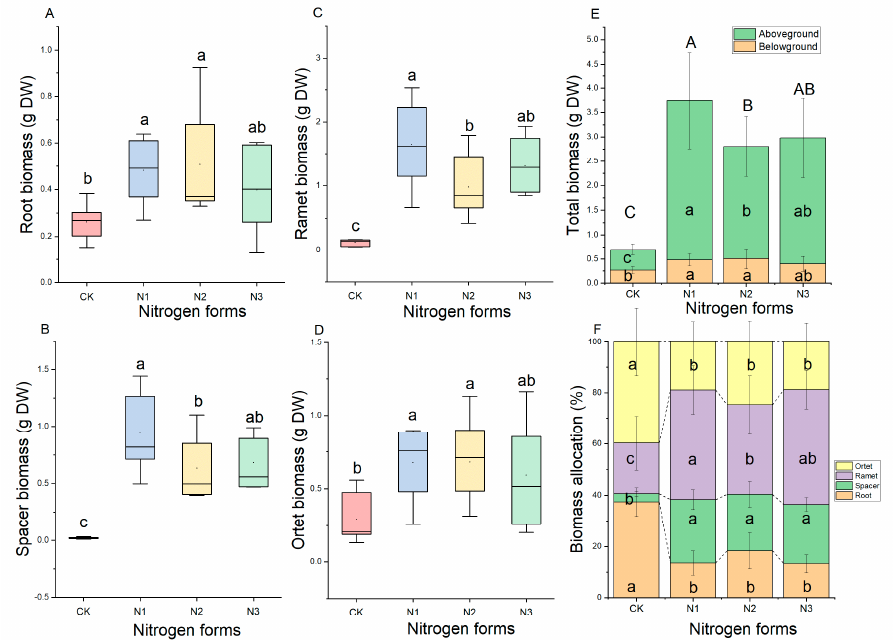
Figure 2. The influence of nitrogen form on biomass and biomass allocation of buffalograss seedlings. Each value is the mean ± SD ( n = 6). CK, -NH 4 NO 3 ; N1, +NO 3 − ; N2, +NH 4+ ; N3, +NH 4 NO 3 . Box plots indicate interquartile range in the box area, median (solid line in the box), mean (solid circle in the box) 25% and 75% percentiles (lower and upper box margins), 10% and 90% percentiles (lower and upper error bars), and outliers (solid rhombus outside the error bars). Note: ( A ): root biomass of buffalograss seedlings in different nitrogen forms. ( B ): spacer biomass of buffalograss seedlings in different nitrogen forms. ( C ): ramet biomass of buffalograss seedlings in different nitrogen forms. ( D ): orter biomass of buffalograss seedlings in different nitrogen forms. ( E ): total biomass of stolon of buffalograss seedlings in different nitrogen forms. ( F ): biomass allocation of buffalograss seedlings in different nitrogen forms. Different lowercase letters indicate a significant difference among different nitrogen forms ( p < 0.05), values designated by different capital letters indicate significant difference of total biomass among nitrogen forms.